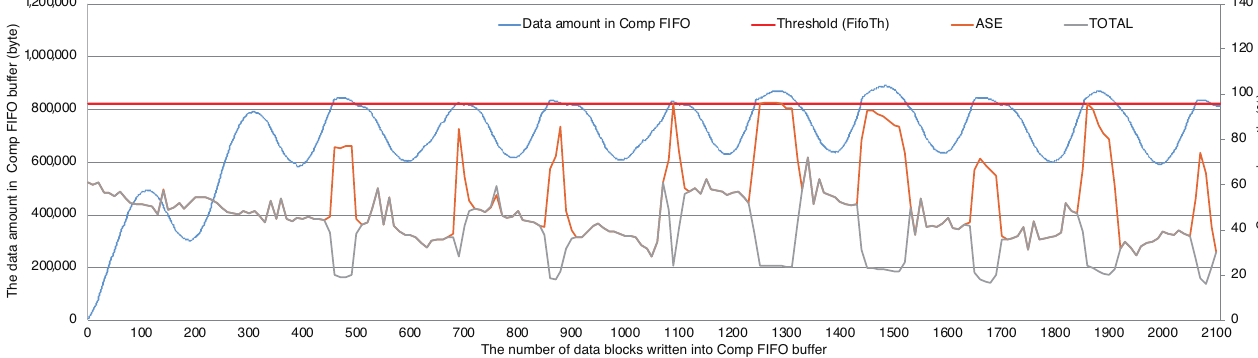
Figure 11. The data amount maintained in Comp FIFO and the compression ratios during the emulation.